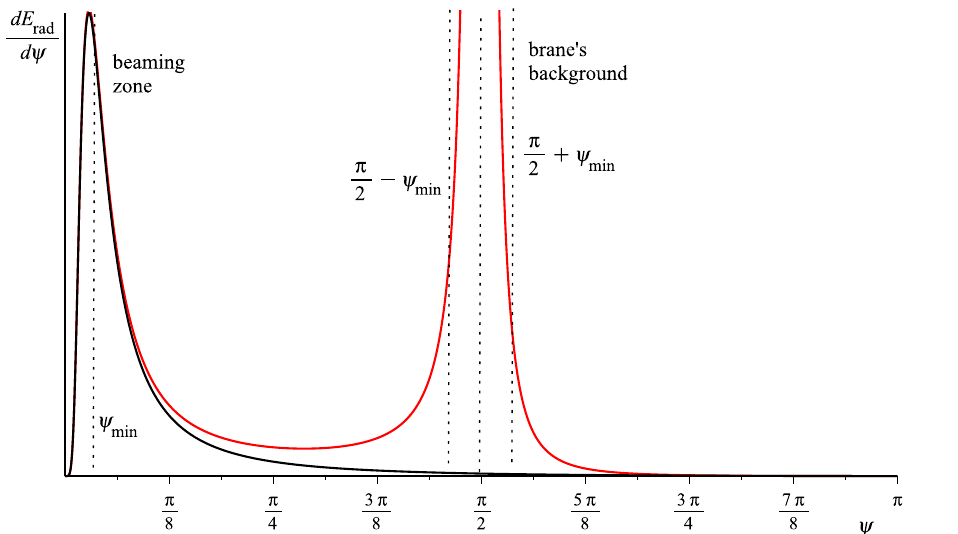
Figure 5 . The total angular distribution of the emitted radiation for full source (red) and reduced one, with no brane excitation (black) for D = 5 ; (cid:13) = 15. Z -symmetric 2